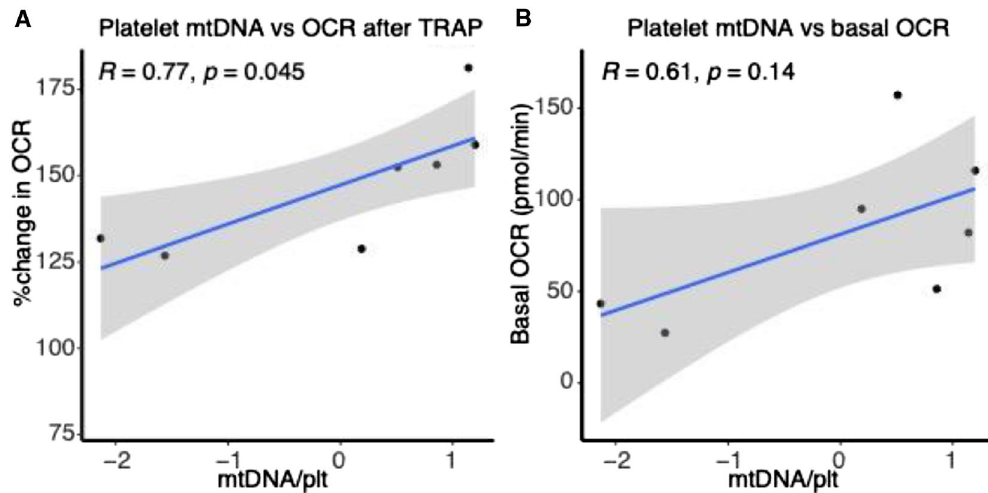
Figure 3. Platelet mitochondrial DNA vs mitochondrial respiration measured by Oxygen consumption rate (OCR in pmol/min). ( A ) Correlation plot showing platelet mitochondrial DNA (mtDNA) with change in oxygen consumption rate (mitochondrial respiration) measured by Seahorse extracellular flux analyzer after ex vivo stimulation with thrombin (TRAP 50 μM). mtDNA was normalized using inverse rank-based transformation and Pearson’s correlation coefficient is shown. ( B ) mtDNA in platelets vs basal OCR in pmol/ min (an average of first three measurements). OCR was measured in triplo and for 5 PLHIV and 2 controls both mtDNA in platelets and real-time measurements of mitochondrial respiration were available and included in the